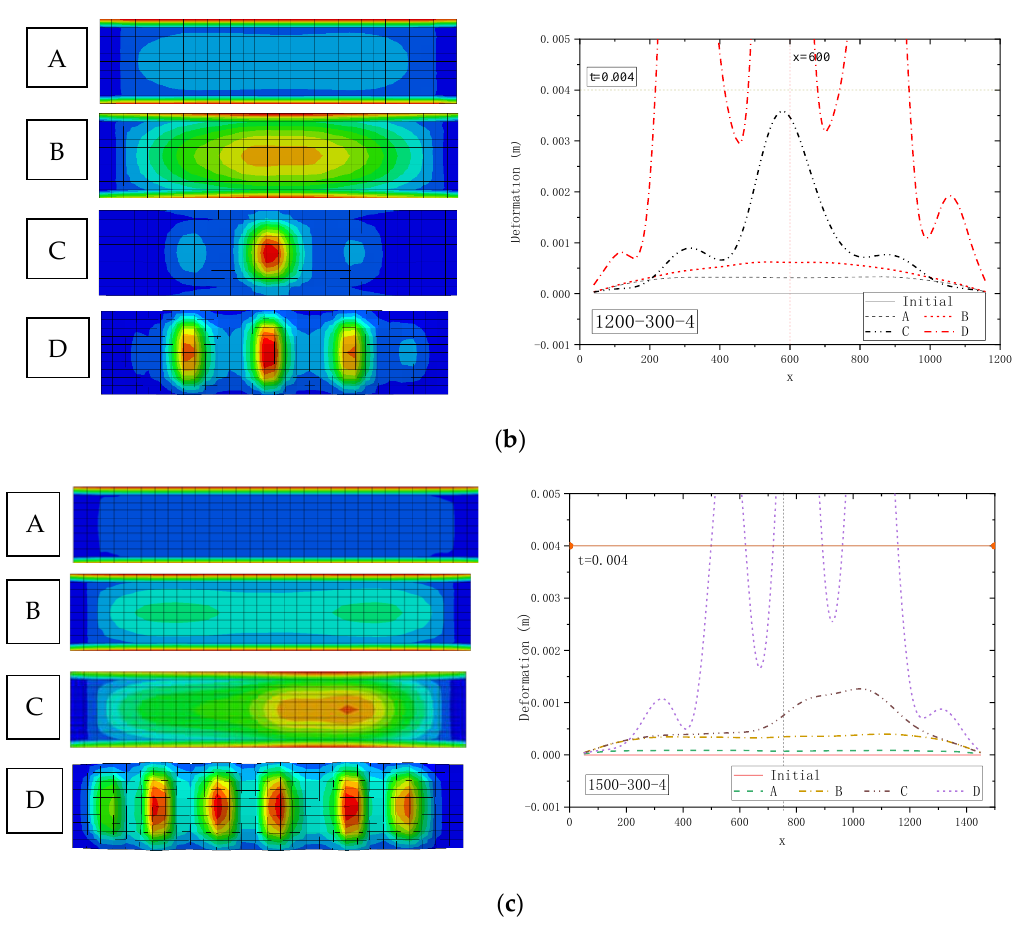
Figure 7. Buckling deformation forms of the side plate under different height-width ratios (A – C are the change of buckling deformation in the loading process, D is the final form). ( a ) 300 × 300 × 900, t = 4. ( b ) 300 × 300 × 1200, t = 4. ( c ) 300 × 300 × 1500, t = 4.